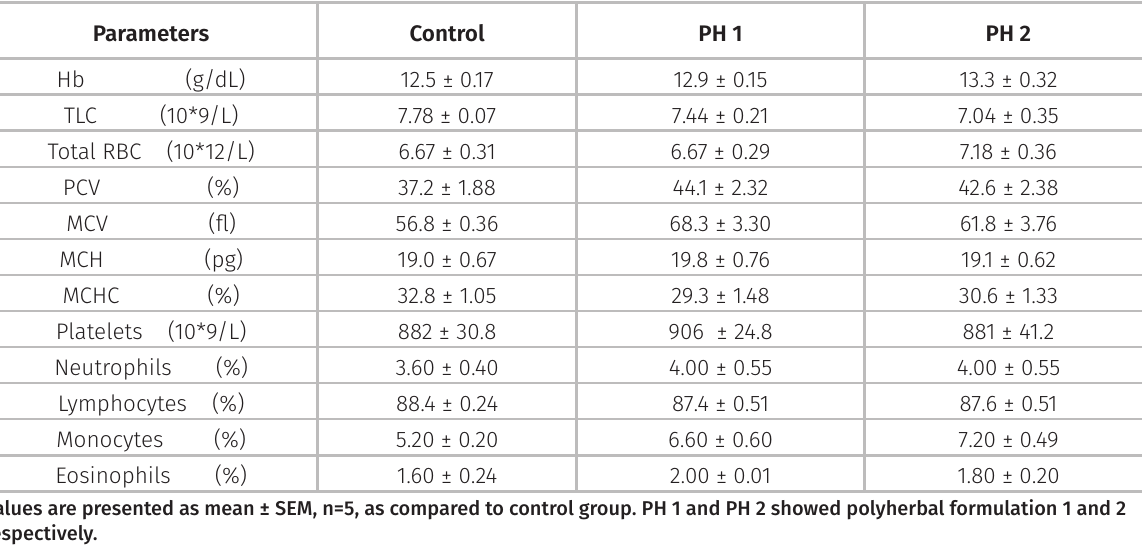
Table V. Effects of polyherbal products on CBC of rats in acute toxicity study.